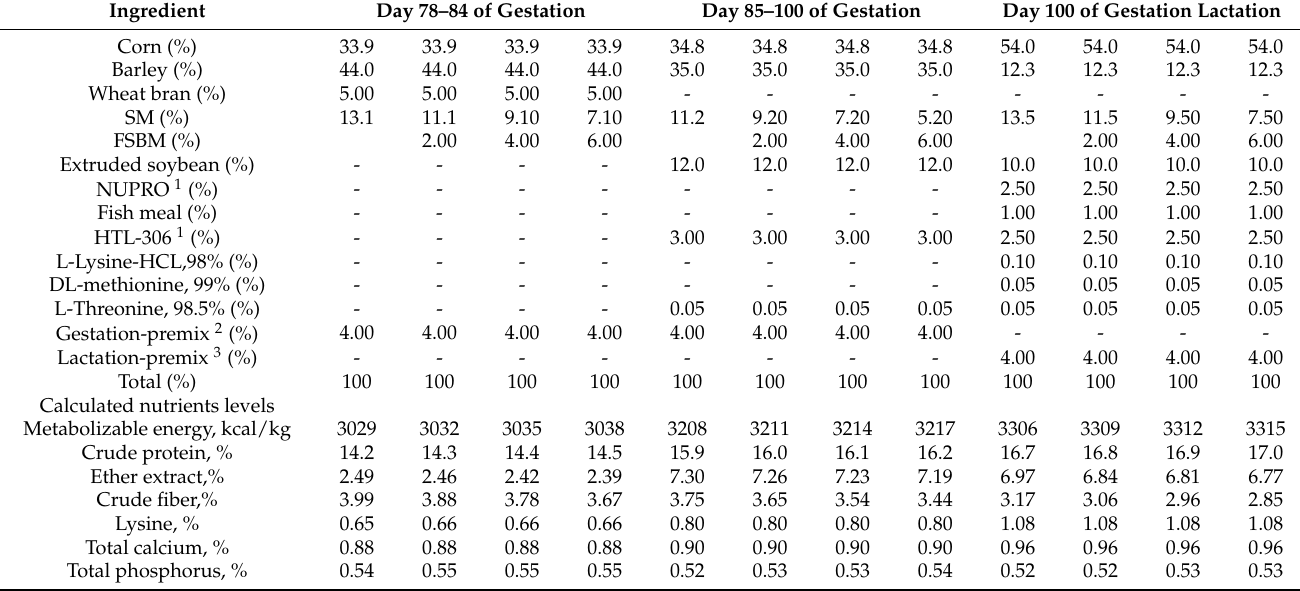
Table 2. Dietary ingredients and nutrient contents of the basal diets (as